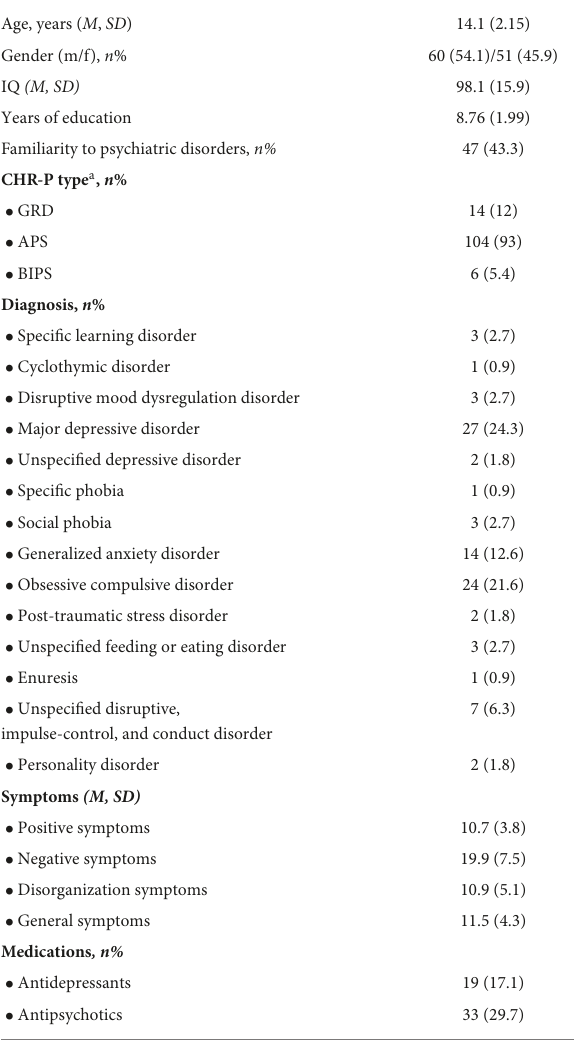
TABLE 1 Demographics and clinical characteristics of